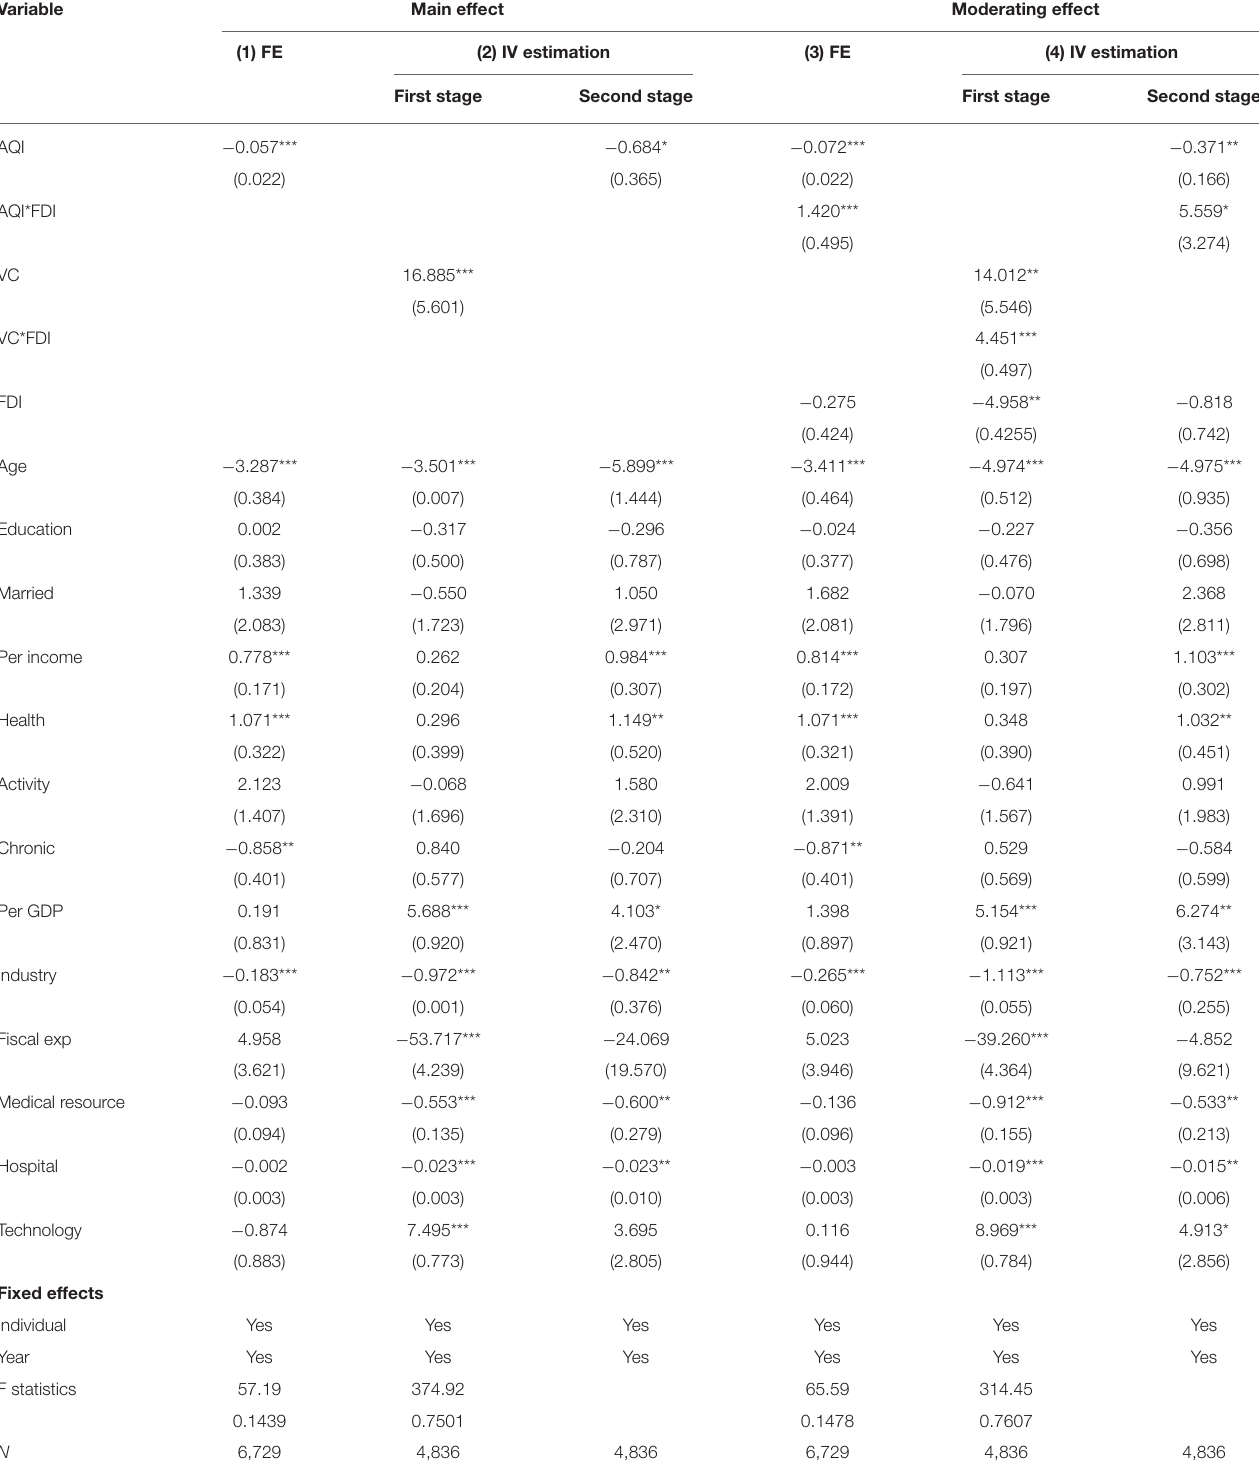
TABLE 3 | Regression results for the main effect and moderating